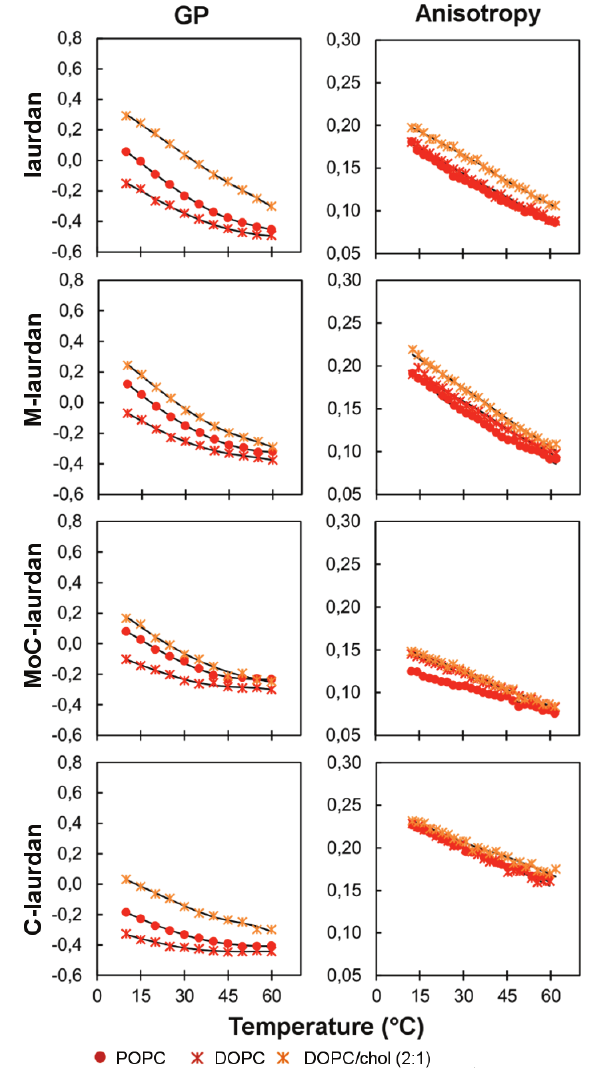
Figure 4. GP and anisotropy of laurdan, M-laurdan, MoC-laurdan and C-laurdan dyes in model membrane in Ld phase (orange/red color codes depicting liquid disordered phases).